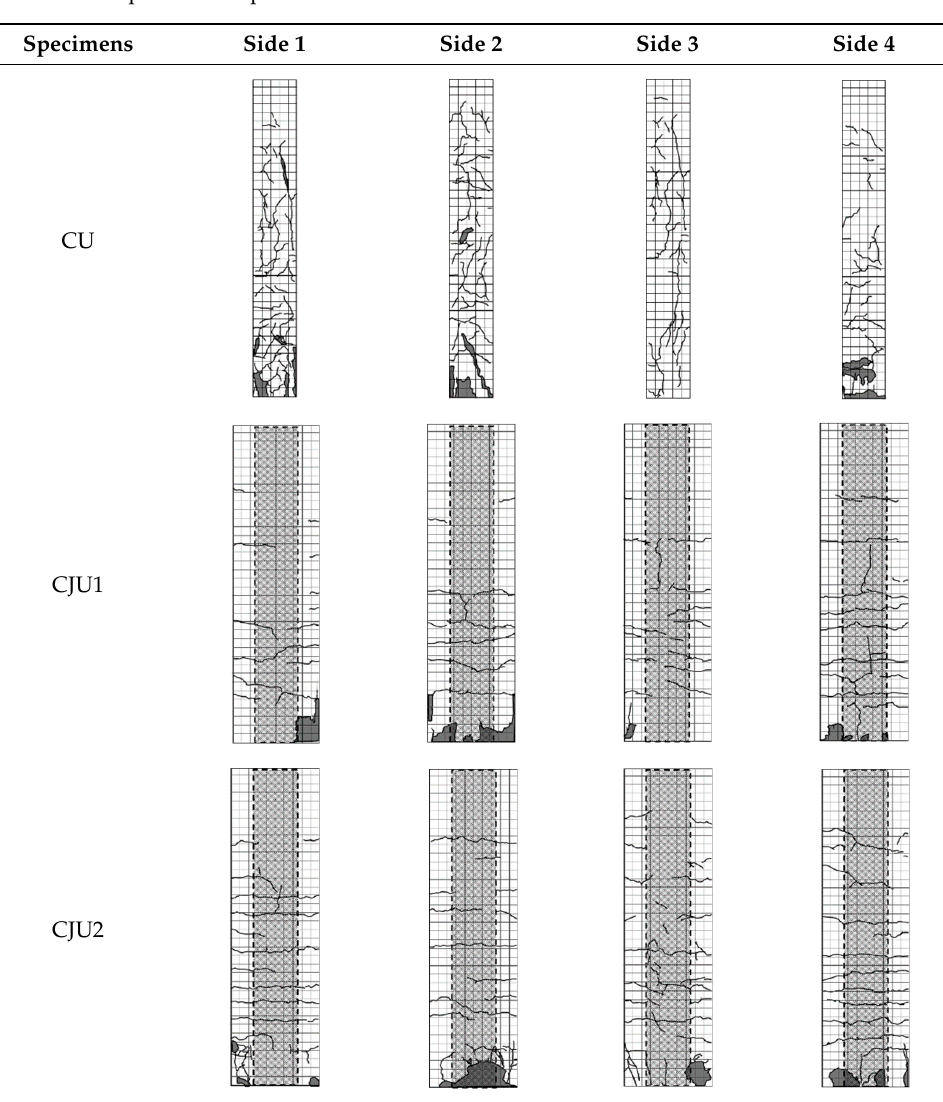
Table 4. Crack patterns of specimens at failure.